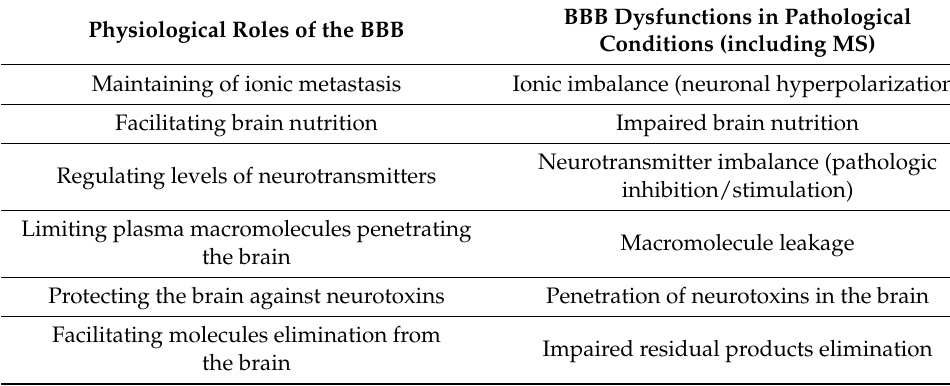
Table 1. Physiological roles of the BBB and its dysfunctions in pathological